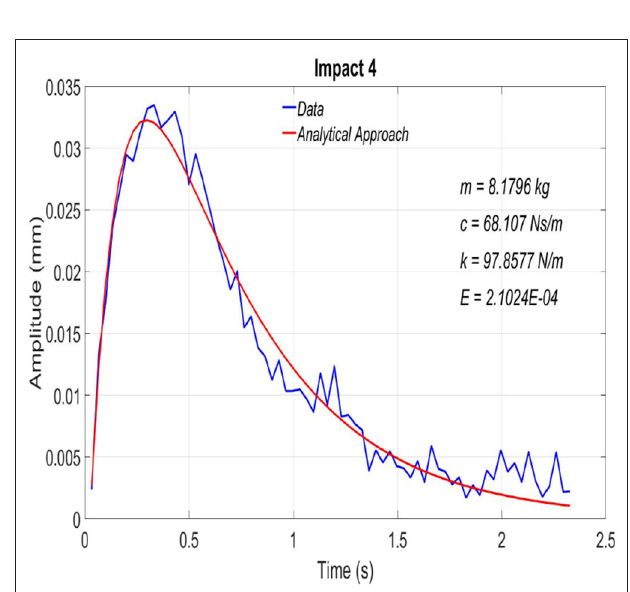
FIGURE 5 | Test 2, Optical characterization (blue) and Analytical results (red).